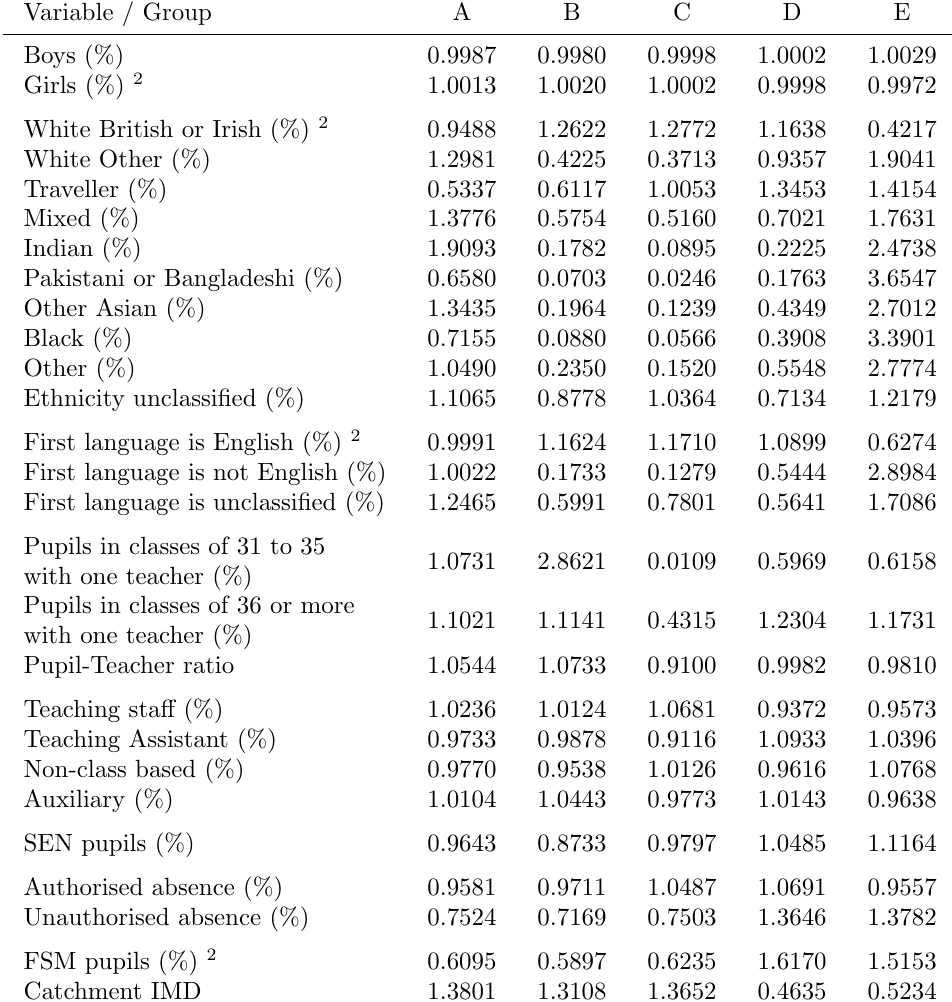
Table 2: Group centres on the standardised